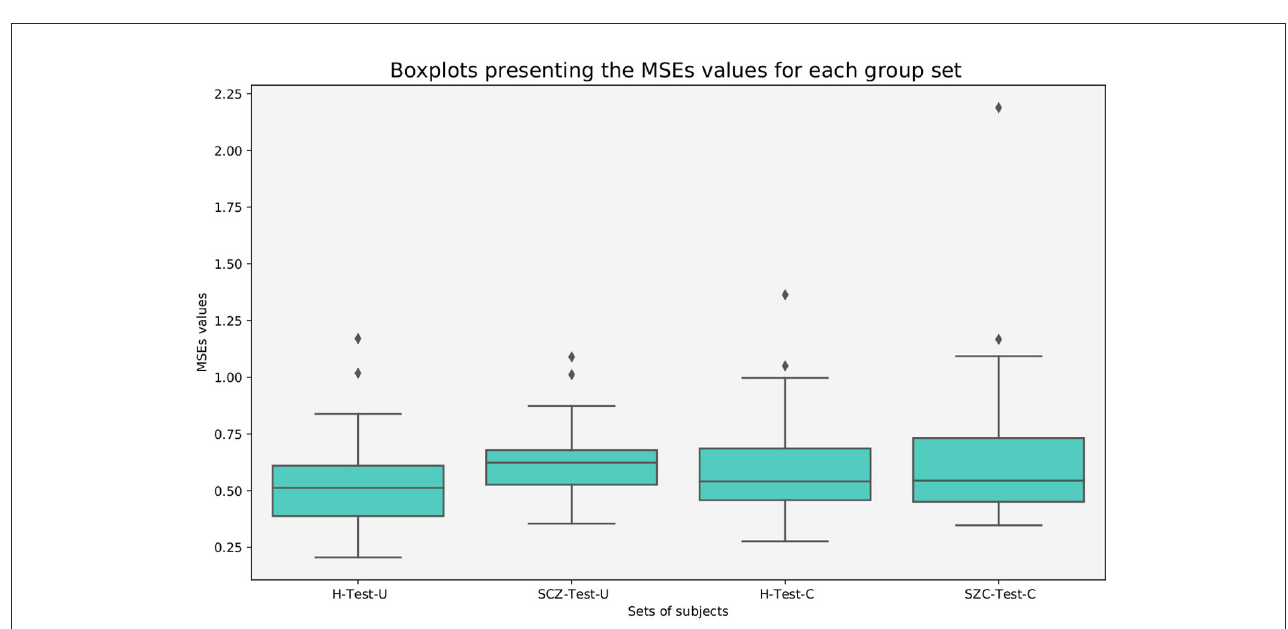
FIGURE7 Boxplots presenting the MSE s values of all subjects, for healthy and SCZ subjects from the UCLA and COBRE datasets.